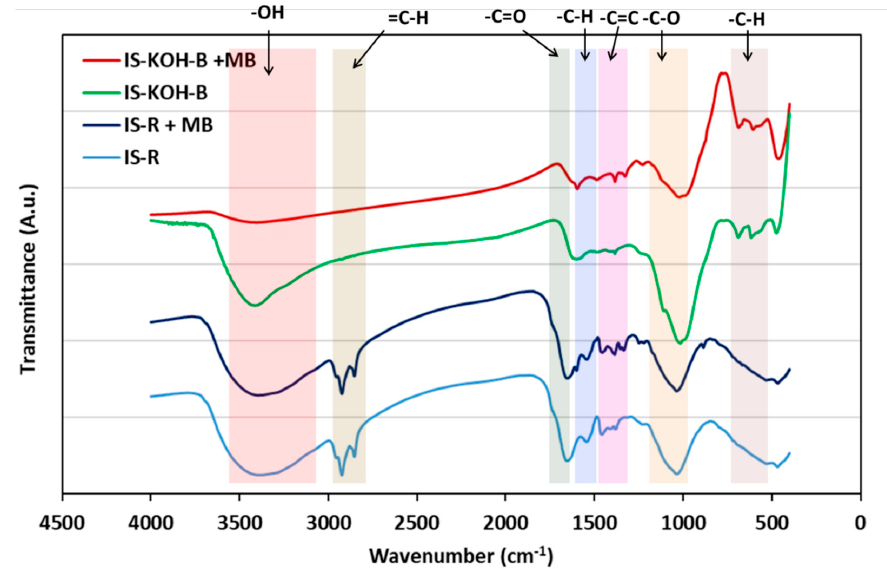
Figure 2. FTIR spectra of IS-R and IS-KOH-B before and after MB adsorption. Significant changes were detected after the thermo–chemical activation process. Ini- tially, a shifting of +23 cm − 1 was noticed for the peak –OH. A similar behavior was noted for –C=O and –C–O band that shifted by − 60 cm − 1 and − 34 cm − 1 , respectively. These find- ings indicate that the pyrolysis process favored oxygen release and carbon fixation. A sim- ilar trend was reported by Wang et al. [44] when producing KHCO 3 -activated biochars.